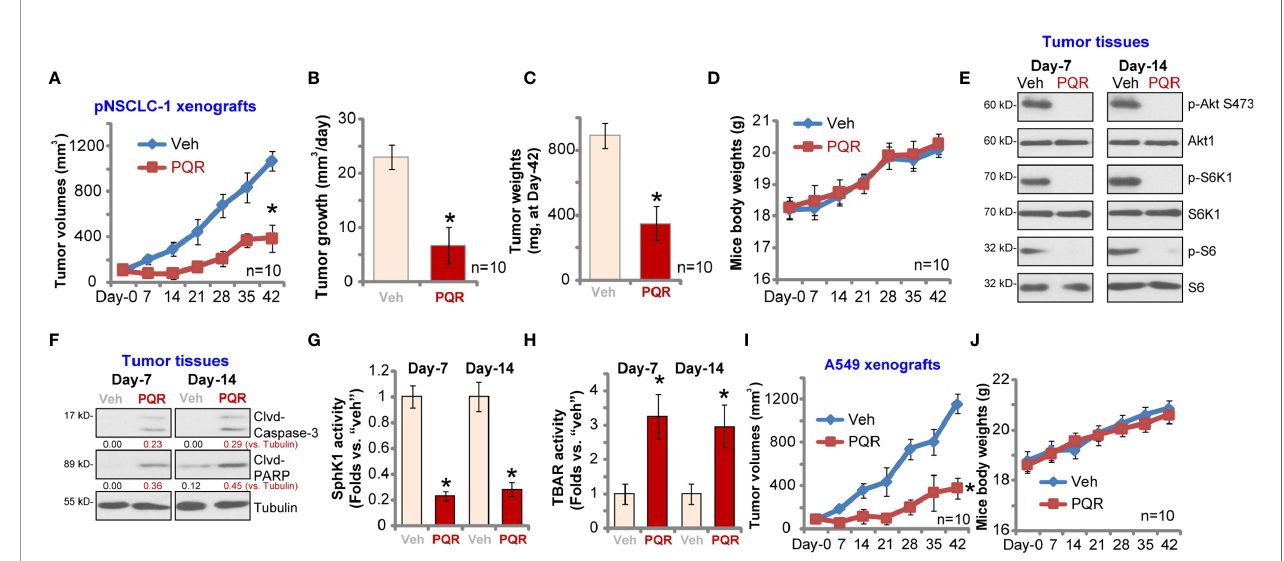
FIGURE 6 | PQR620 administration inhibits NSCLC xenograft growth in SCID mice. SCID mice bearing pNSCLC-1 xenograft tumors (A – H) or A549 xenograft tumors (I , J) were administrated with PQR620 (oral gavage, 30 mg/kg, daily for 21 days, “ PQR ” ) or vehicle control ( “ Veh ” ). Tumor volumes (A , I) and mice body weights (D , J) were recorded at every seven days for a total of 42 days. For pNSCLC-1 xenografts, the estimated daily tumor growth, in mm 3 per day, was calculated by the described formula (B) ; At day-42, pNSCLC-1 xenografts were individually isolated and weighted (C) . Expression of listed proteins in pNSCLC-1 xenograft tumor tissues was tested by Western blotting assays (E , F) ; Relative SphK1 activity (G) and TBAR activity (H) were tested as well, with results normalized. Data were presented as mean ± standard deviation (SD). Ten mice were in each group (n = 10) (A – D , I , J) . * p < 0.05 vs. “ Veh ”